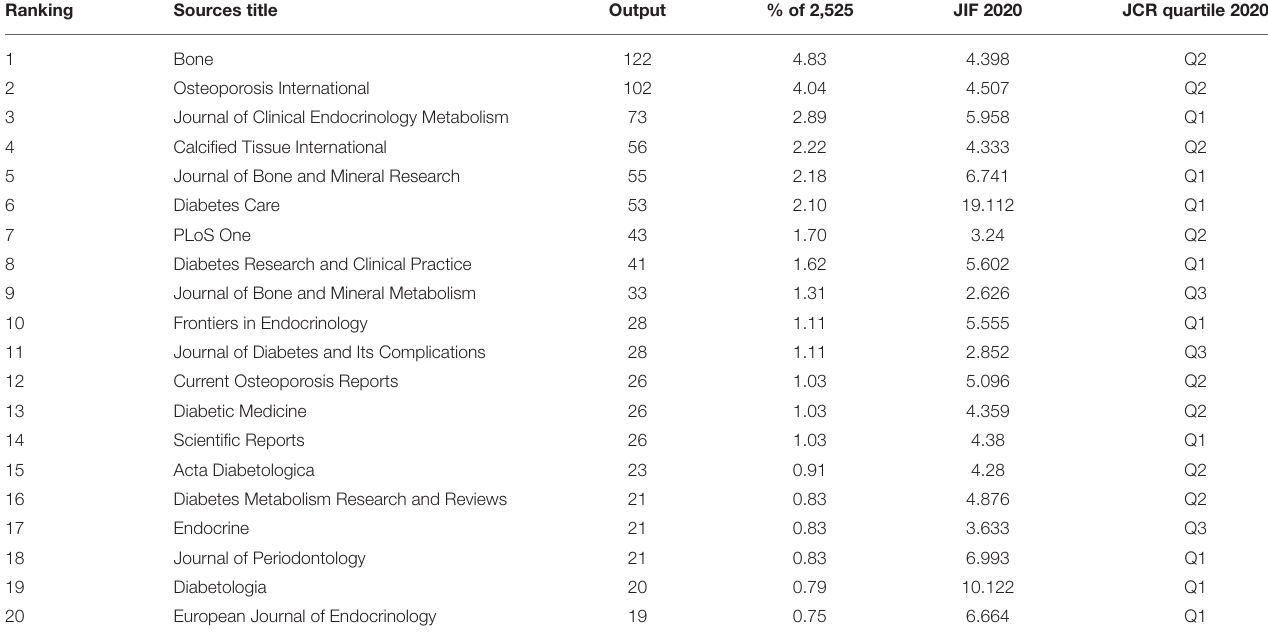
TABLE 2 | Top 20 most productive journals in BMDM field. Ranking